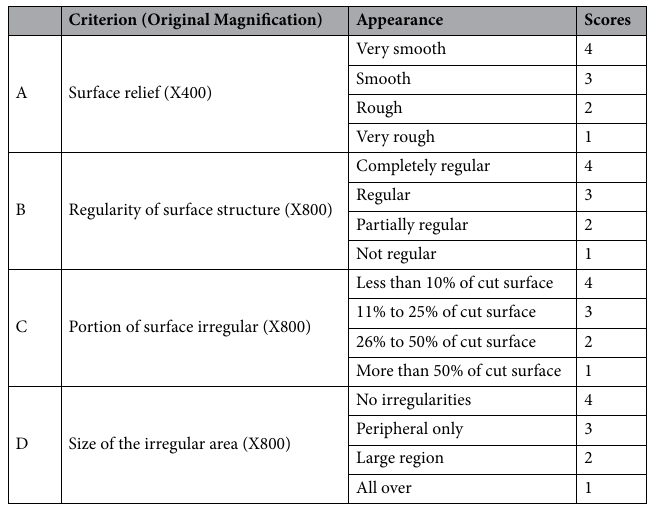
Table 1. Modified scoring system for the quality of the